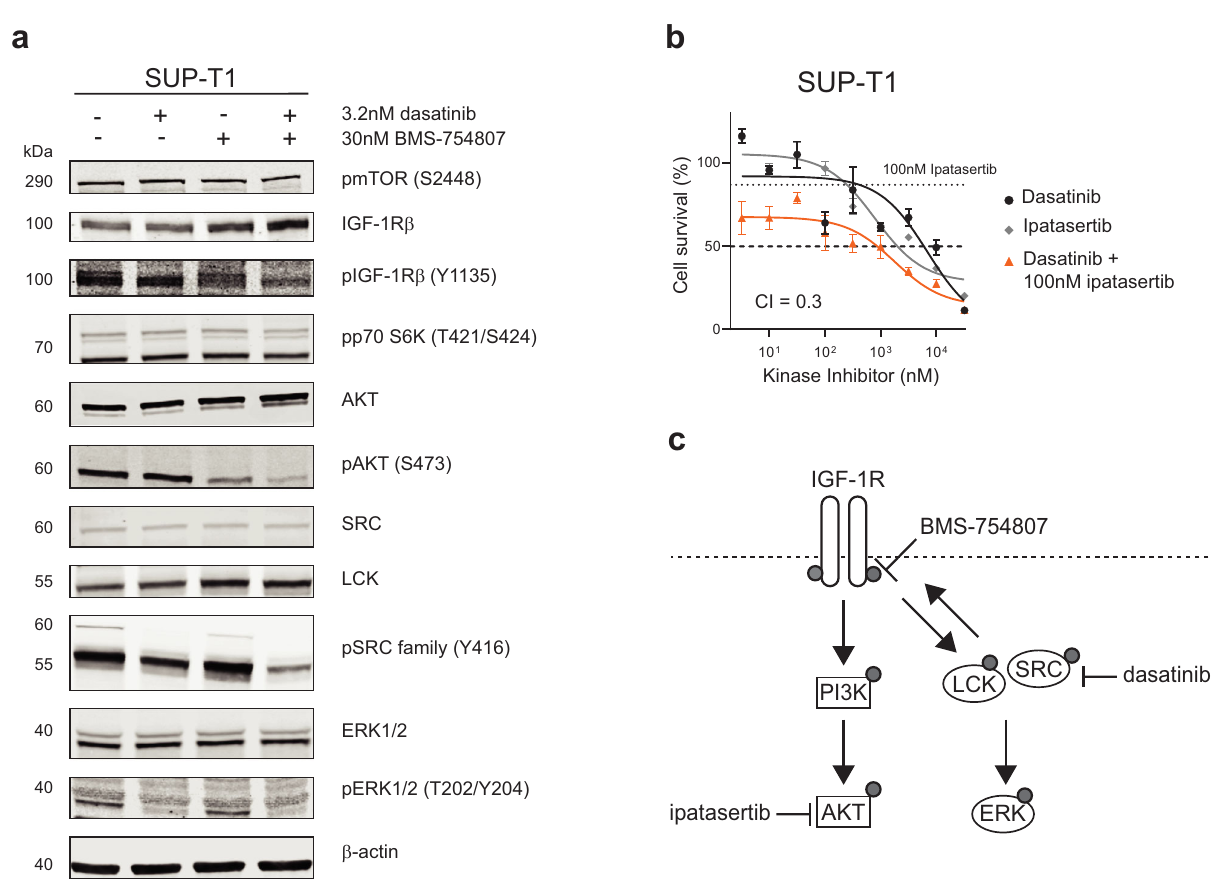
Fig. 5 Concomitant inhibition of SFKs and IGF-1R inhibits AKT. a Western blot of SUP-T1 cells treated with dasatinib, BMS-754807 or combination treatment. Cells were incubated for 72 h with 3.2 nM dasatinib, 30 nM BMS-754807 or combined 3.2 nM dasatinib and 30 nM BMS-754807. 50 µ g